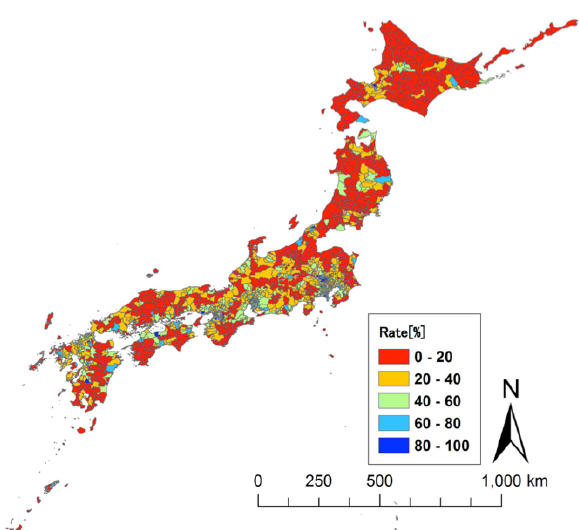
Figure 8. Rates of drugstores that satisfy the survival conditions in 2010